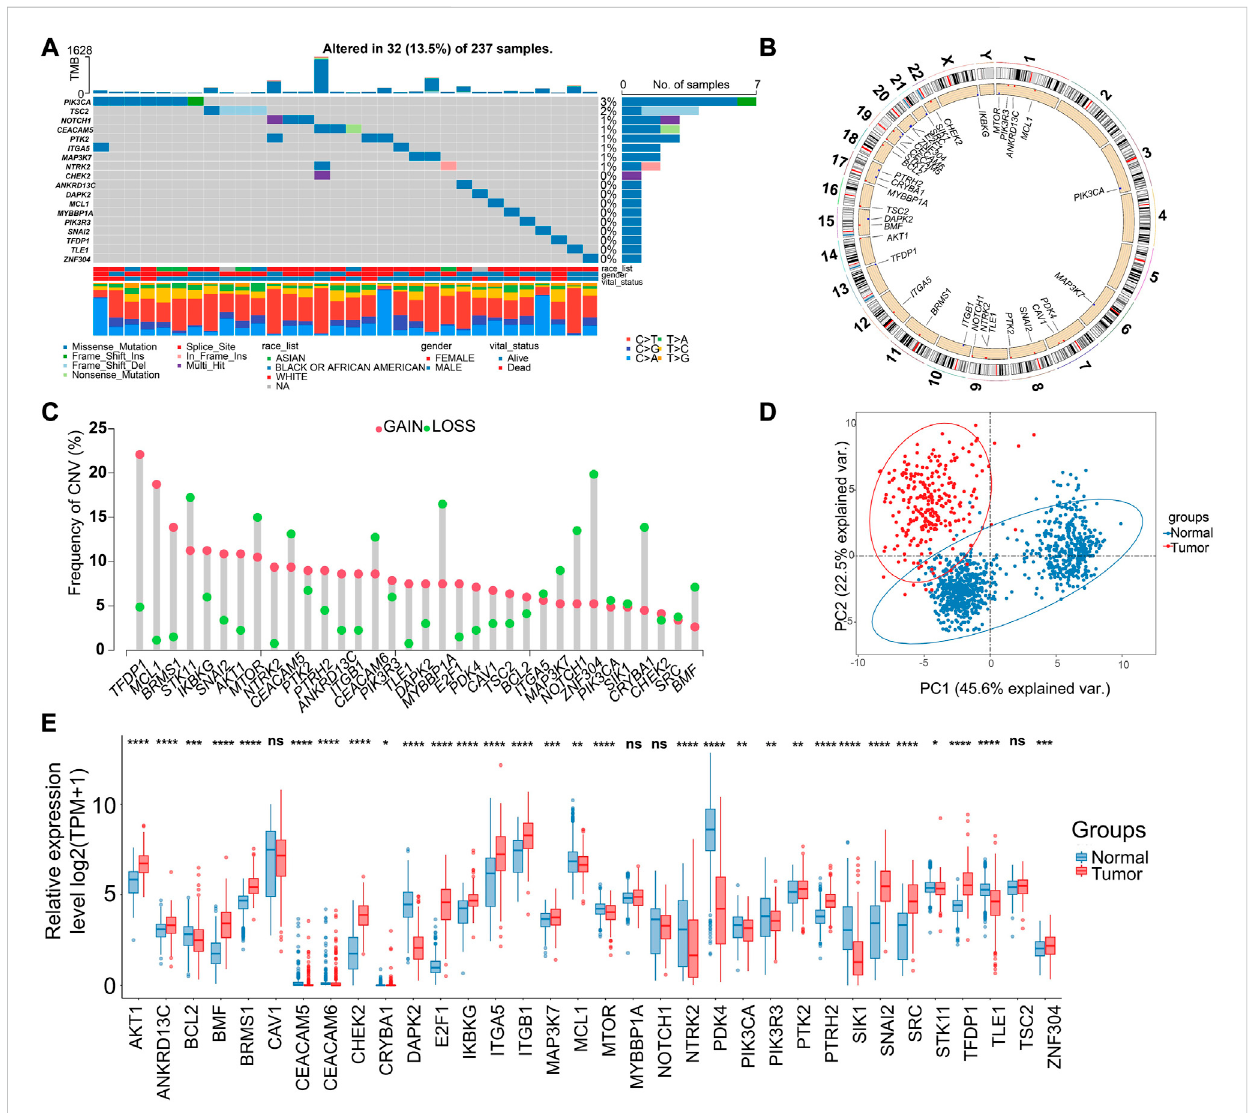
FIGURE 2 Genomic and transcriptional landscapes of ARGs in soft-tissue sarcoma (STS) in TCGA database. (A) The mutation frequency of ARGs (Top 18) in 237 patients with STS in TCGA database. (B) The speci fi c location of ARGs on the human chromosomes. (C) The SCNV of ARGs in patients with STS in TCGA database. Red indicates CNV gain, and green indicates CNV loss. (D) The principal component analysis (PCA) of ARGs expression to identify tumor among normal samples based on the TCGA-GTEx database. Red indicates tumor samples, blue indicate normal tissues. (E) The expression of ARGs between tumor (red) and normal samples (blue) based on the TCGA-GTEx database. *, 0.01 ≤ p < 0.05; **, 0.001 ≤ p < 0.01; ***, 0.0001 ≤ p < 0.001; ****, p < 0.0001; ns, p ≥